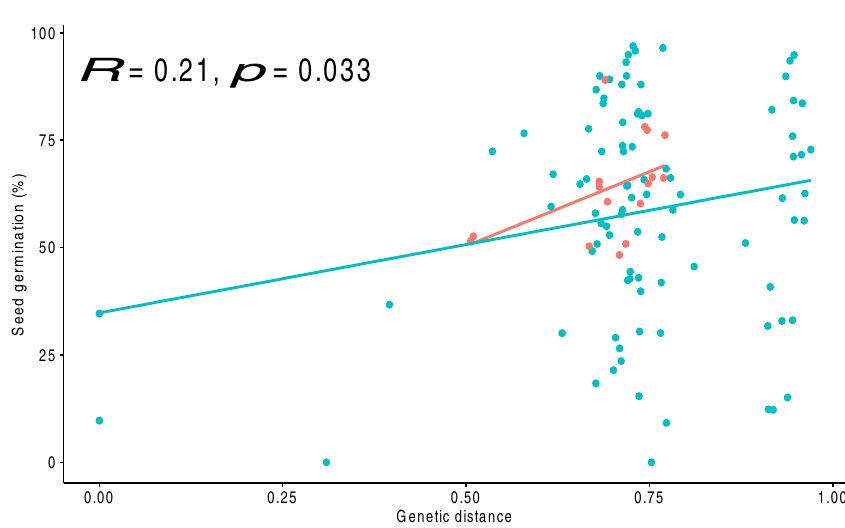
Figure 7. Correlation between the parents’ genetic distance and seed germination rates in Dioscorea